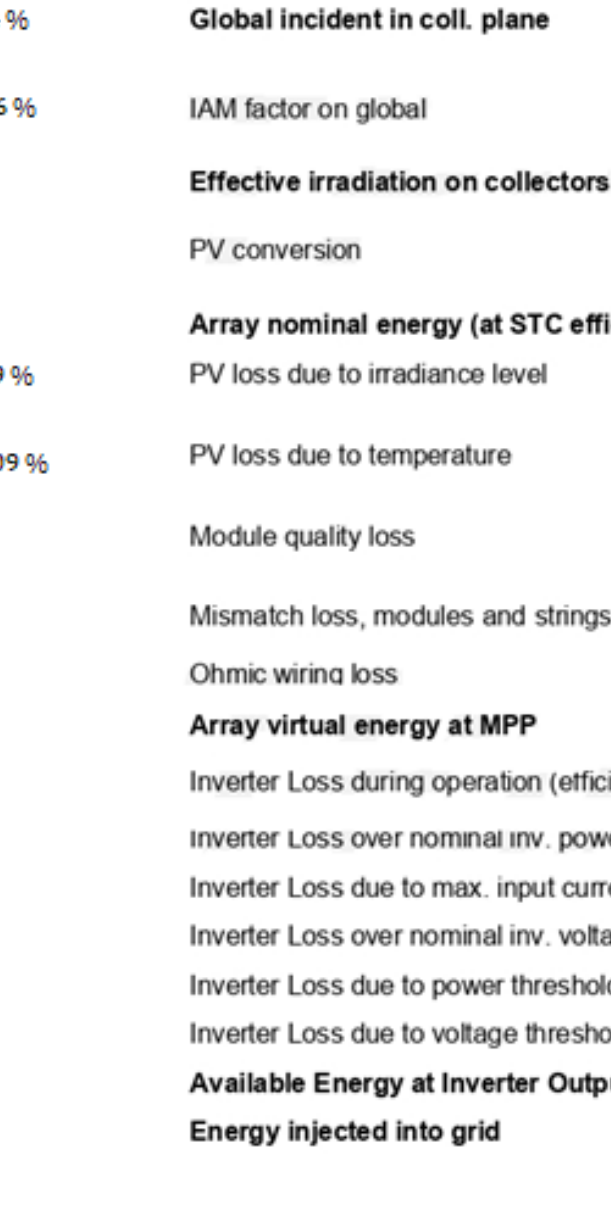
Figure 11. Loss diagram for the Meybod area.